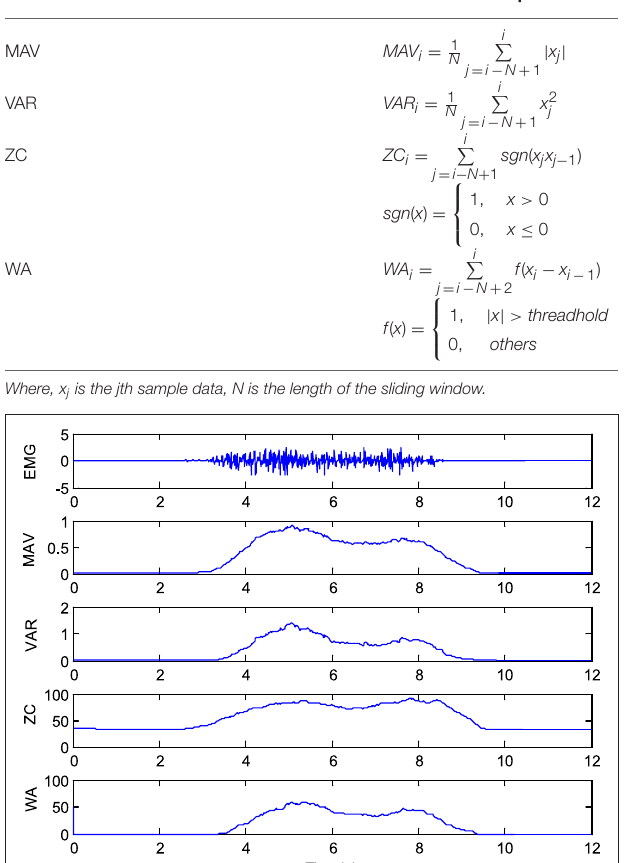
TABLE 2 | The EMG features in time domain and mathematical equation. Feature